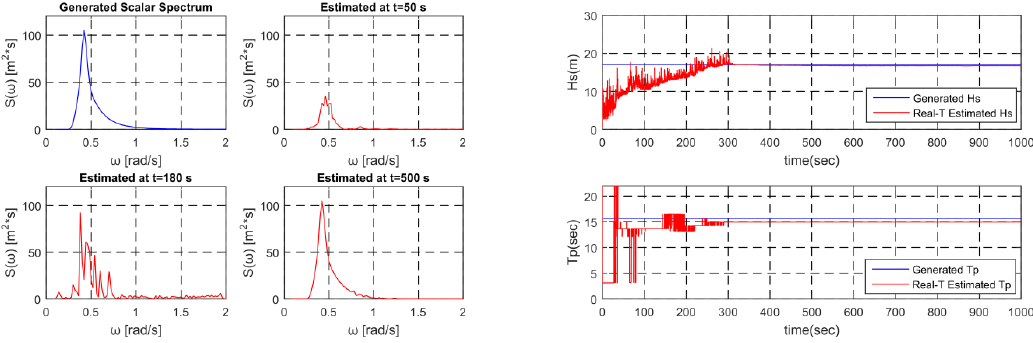
Figure 26. Generated and estimated spectrum/Evolution of parameters (Sea sate 5, Hs = 17 m, Tp = 15 s).